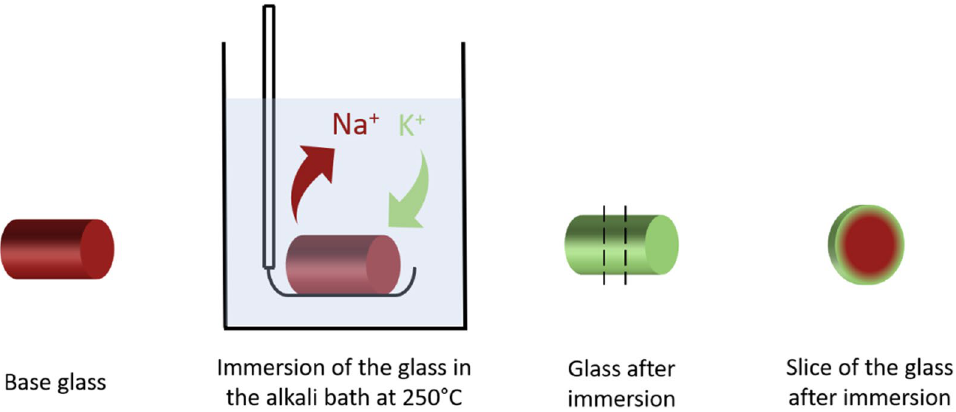
Figure 2. Experimental process of the ionic exchange and characterization.